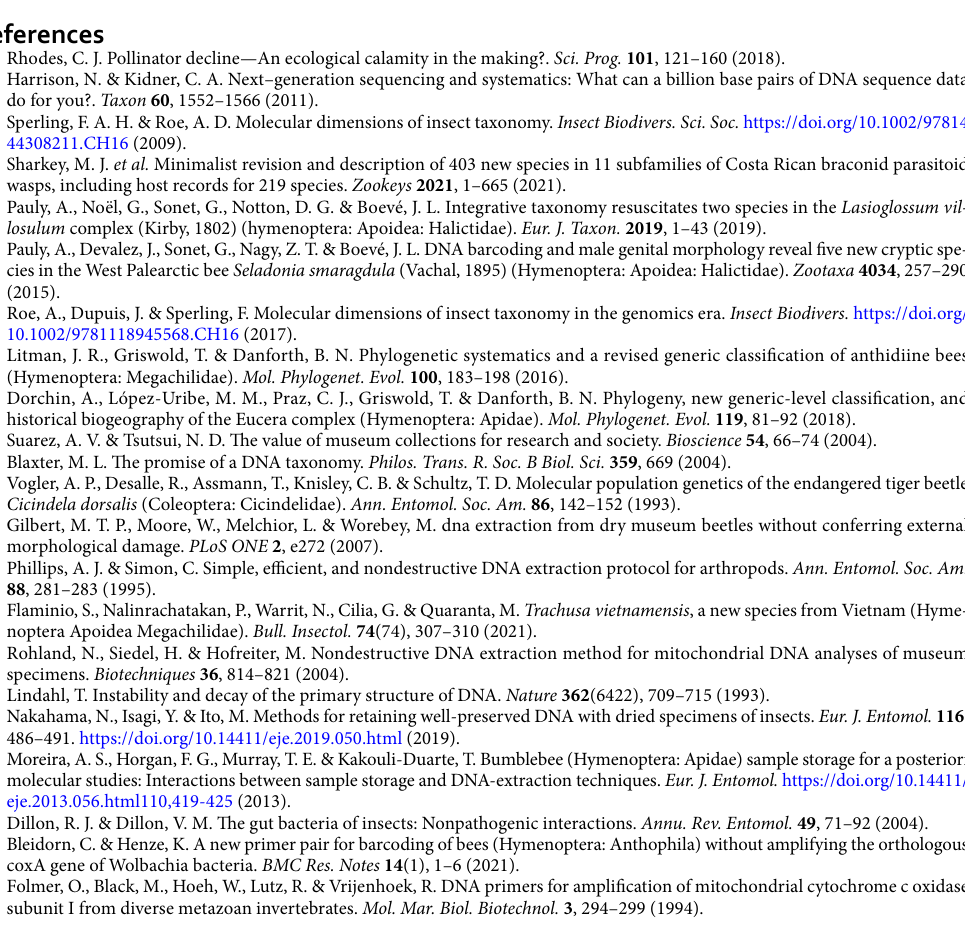
(using megablast algorithm) 24 and compared to sequences deposited in the Barcode of Life Data Systems (BOLD Systems) 25 .